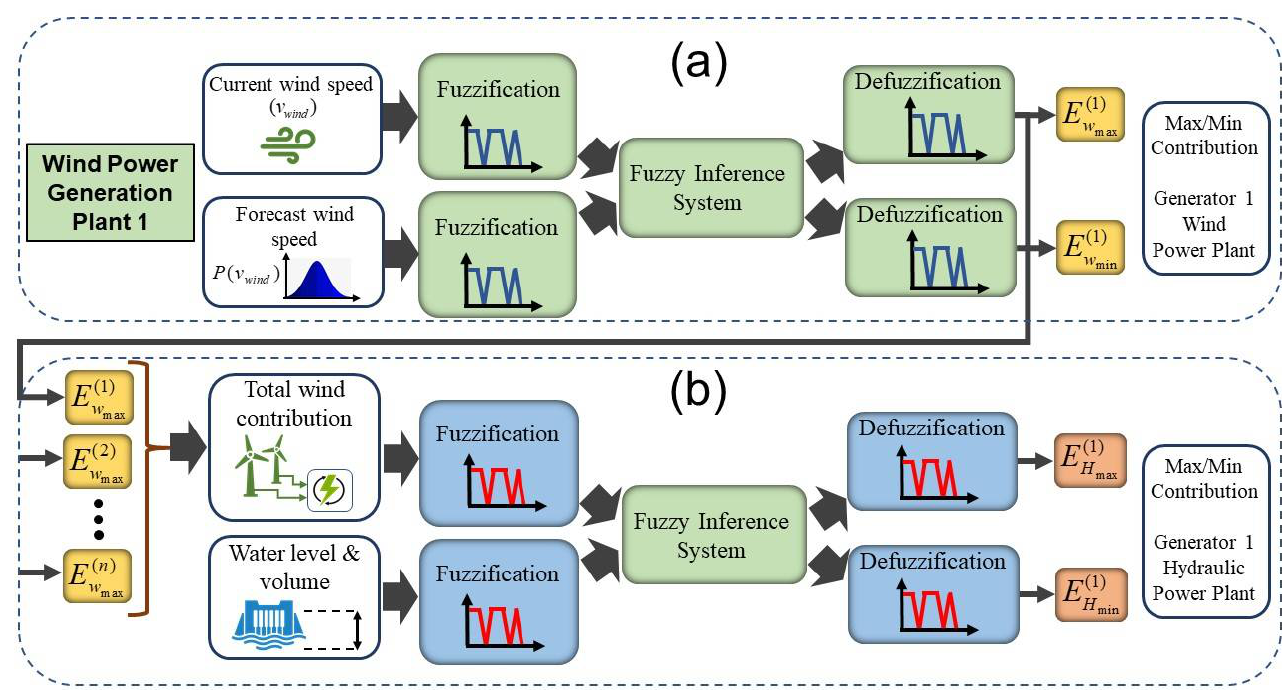
Figure 2. Power generation modeling based on FL methodology for ( a ) wind power plants; ( b ) hydroelectric power plants.